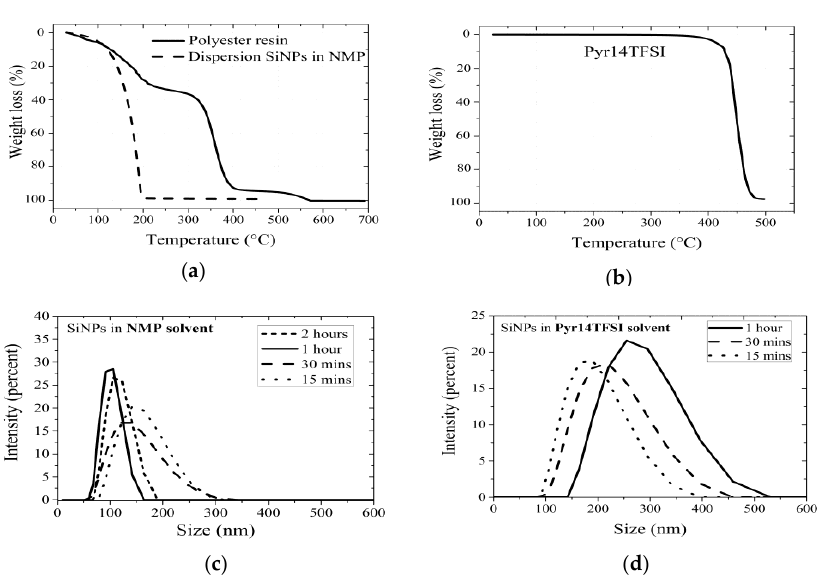
Figure 3. ( a ) TGA curves for polyester resin (solid line) and Si particles in NMP (dotted line); ( b ) TGA curve for Pyr14TFSI; ( c ) DLS size distribution of Si particles in NMP solvent; ( d ) DLS size distribution of Si particles in Pyr14TFSI solvent.